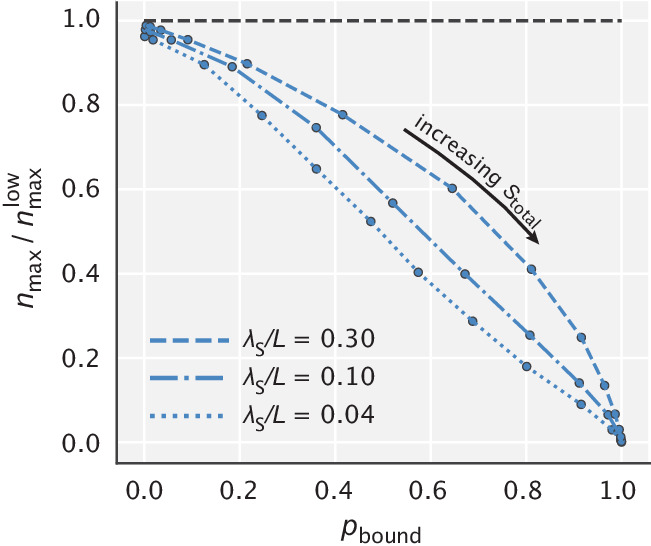
Reduction in the peak effective number of proofreading realizations as a function of pbound.nmaxlow represents the peak value of neff in the limit of low substrate concentration (the maximum of the solid blue curve in Appendix 5—figure 3).